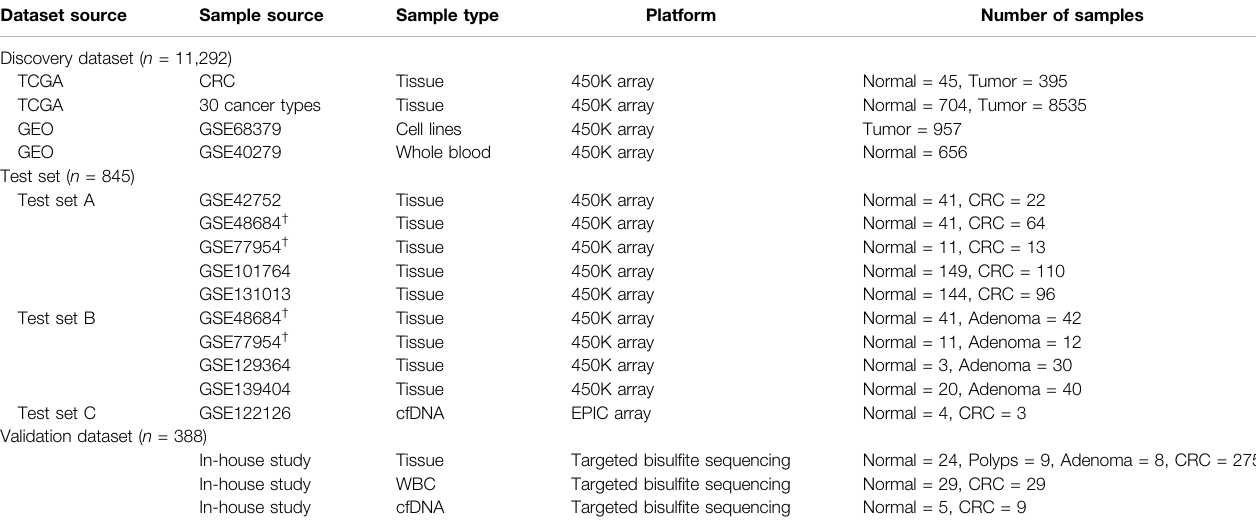
TABLE 1 | The basic information of datasets used in the current